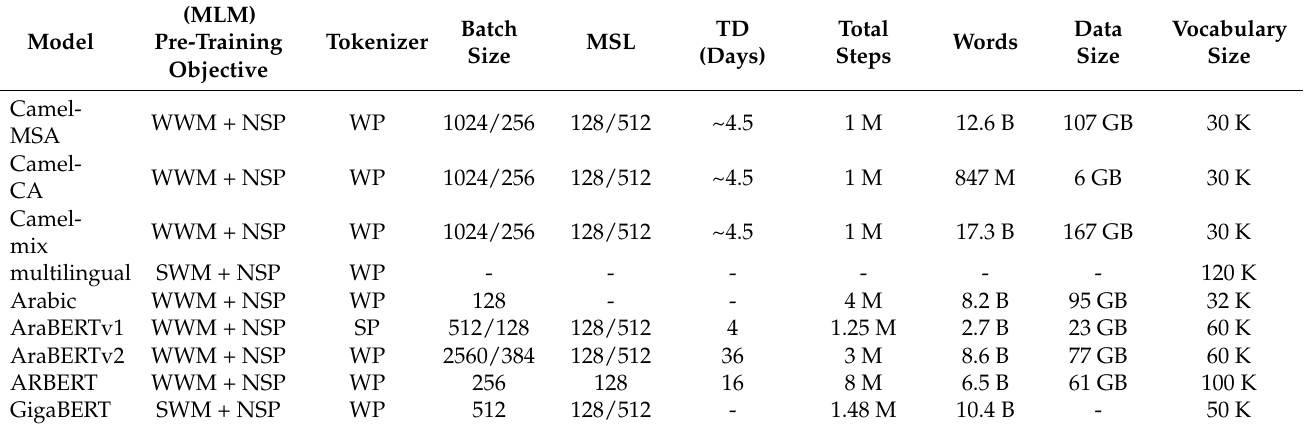
Table 10. Arabic BERT models configurations. MLM: masked language modeling. WWM: whole